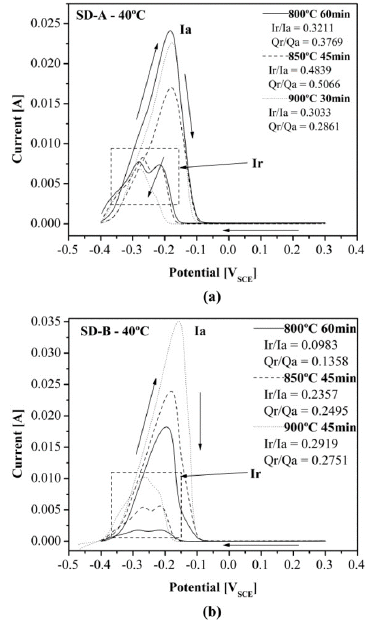
Figure 13. DL-EPR cycles of (a) SD-A and (b) SD-B with I and